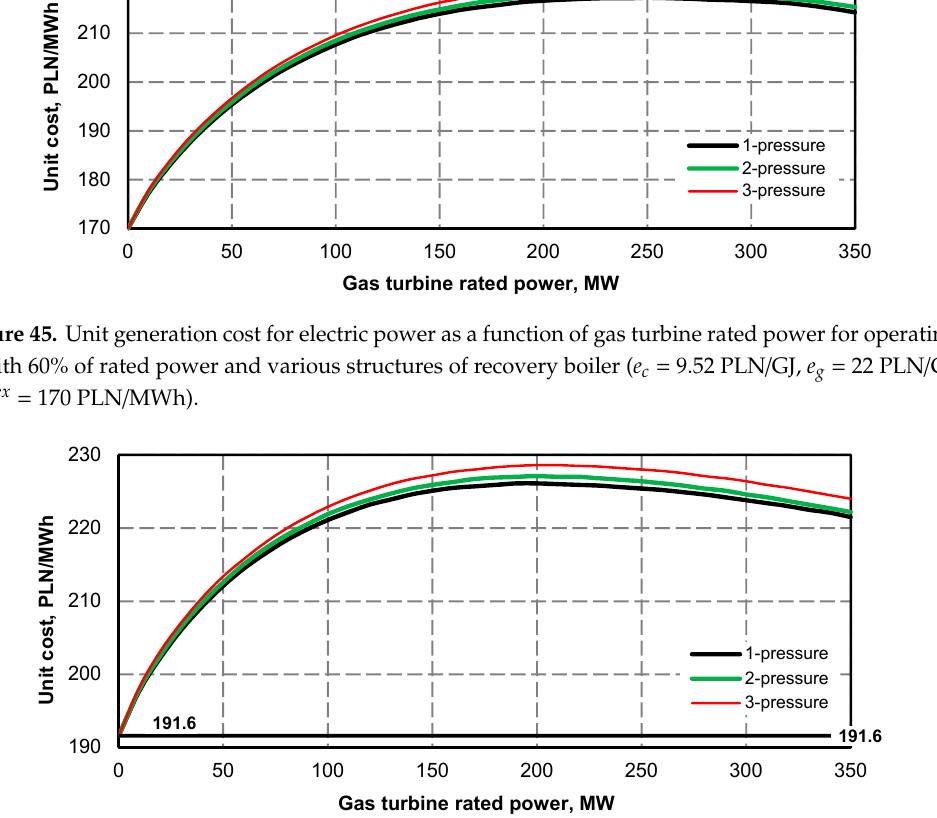
Figure 46. Unit generation cost for electric power as a function of gas turbine rated power for operating it with 60% of rated power and various structures of recovery boiler ( e c = 12 PLN / GJ, e g = 27.7 PLN / GJ, (k el ) ex = 191.6 PLN/MWh).